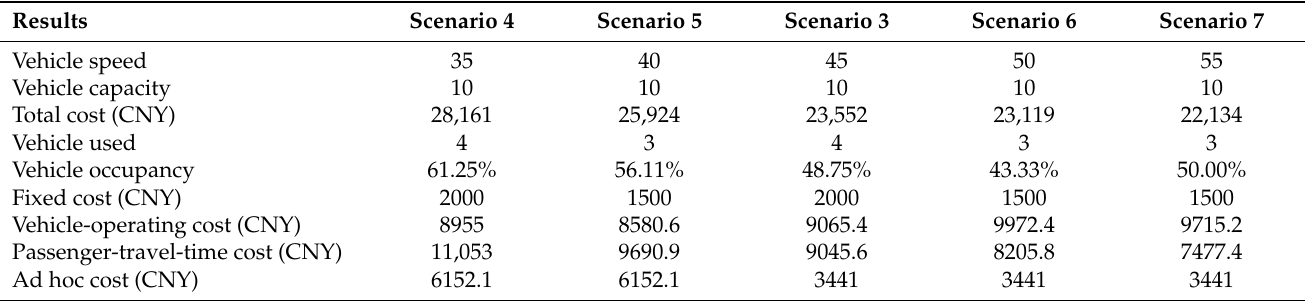
Table 6. Results under different vehicle